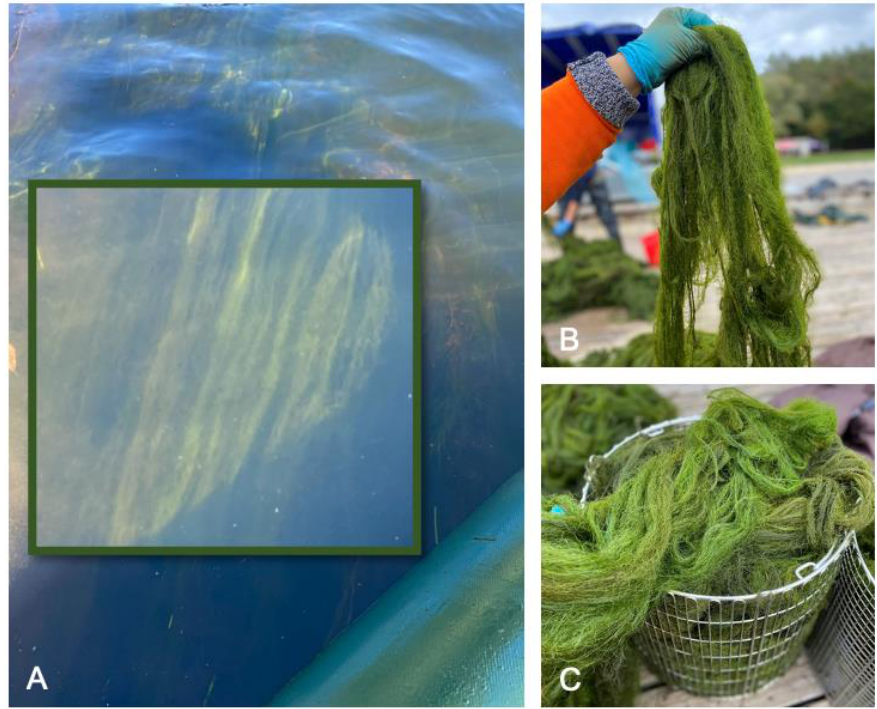
Figure 1. ( A ) Agglomerations of macroalgal C. glomerata biomass in River Šventoji; ( B ) Collected C. glomerata biomass; ( C ) Washed and cleaned biomass of